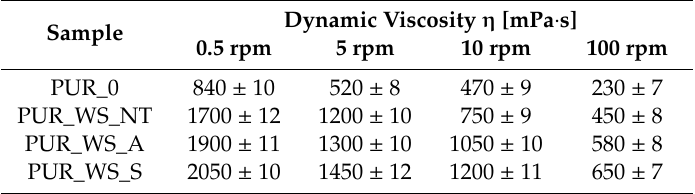
Table 3. Dynamic viscosity of PUR